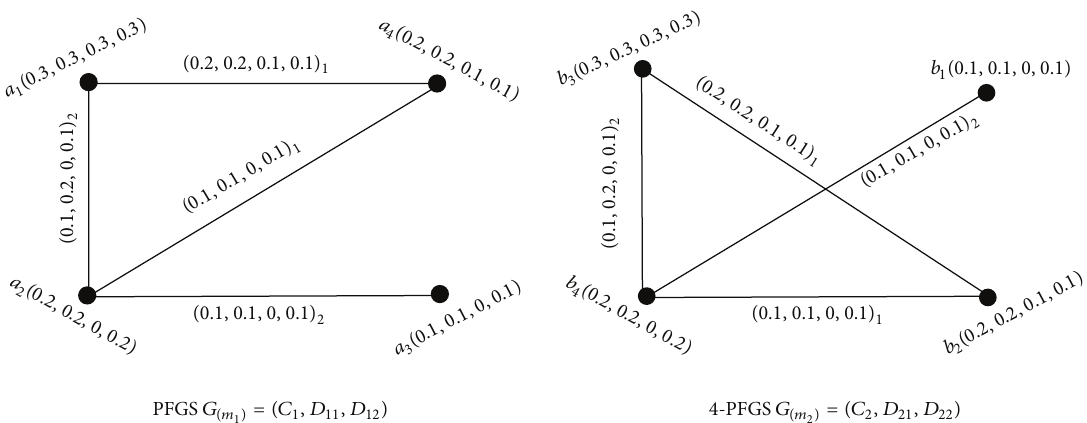
Figure 7: Identical 4-polar fuzzy graph